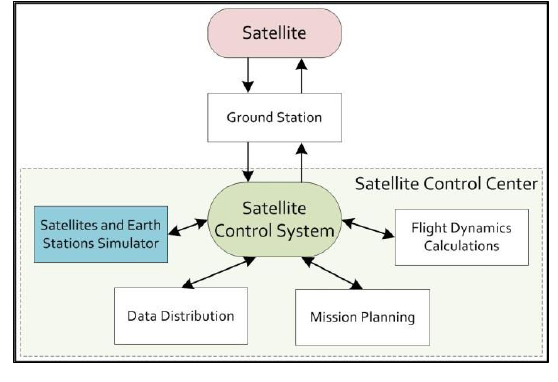
Fig. 2. Satellite Control Center Elements